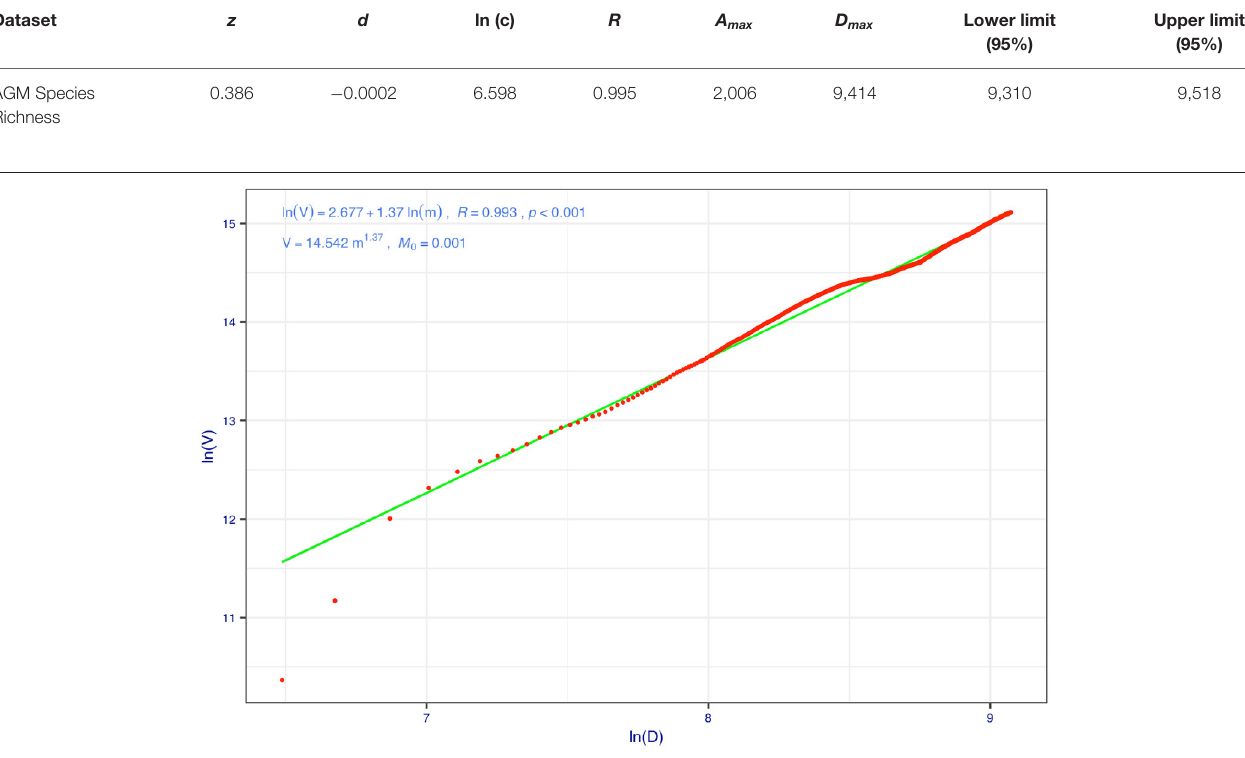
TABLE 3 | The power law with exponential cutoff for diversity-area relationship (PLEC-DAR) model fitted with 1,000 times of re-sampling of the American gut microbiome (AGM) datasets consisting of 1,473 AGM samples, augmented with Taylor’s power law (TPL) to obtain the 95% CIs.